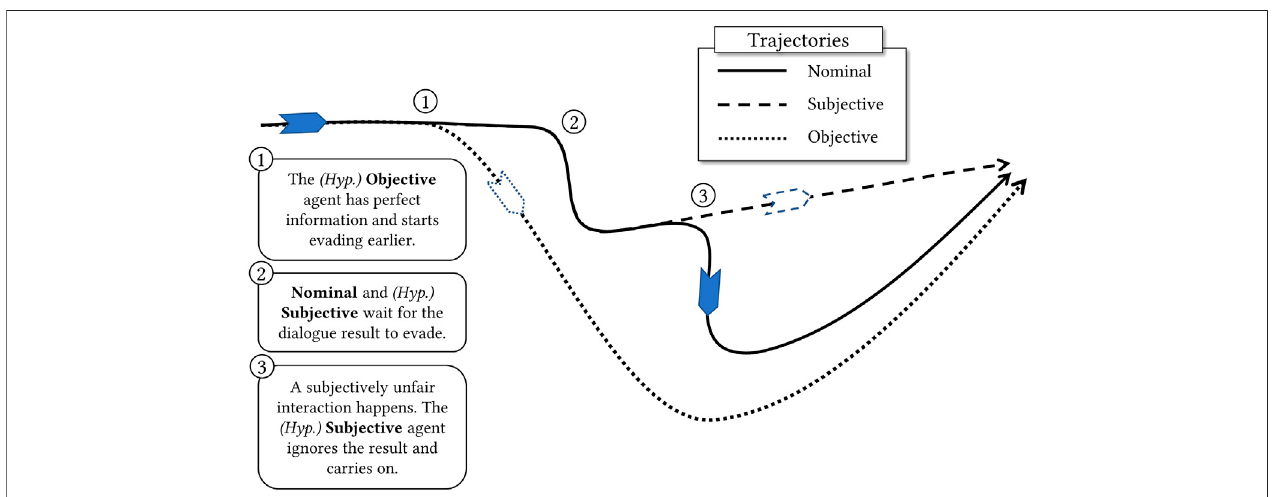
FIGURE 7 | An example of a Nominal trajectory and its hypothetical Subjective and Objective scenarios. The full line (Nominal) represents the actual trajectory performed by the agent in their trial. The Objective hypothesis (dotted line) can perform smoother manoeuvres and evade much sooner due to perfect information being immediately available at r max . The Subjective hypothesis (dashed line) behaves like the Nominal trajectory, but will not concede upon subjective unfairness